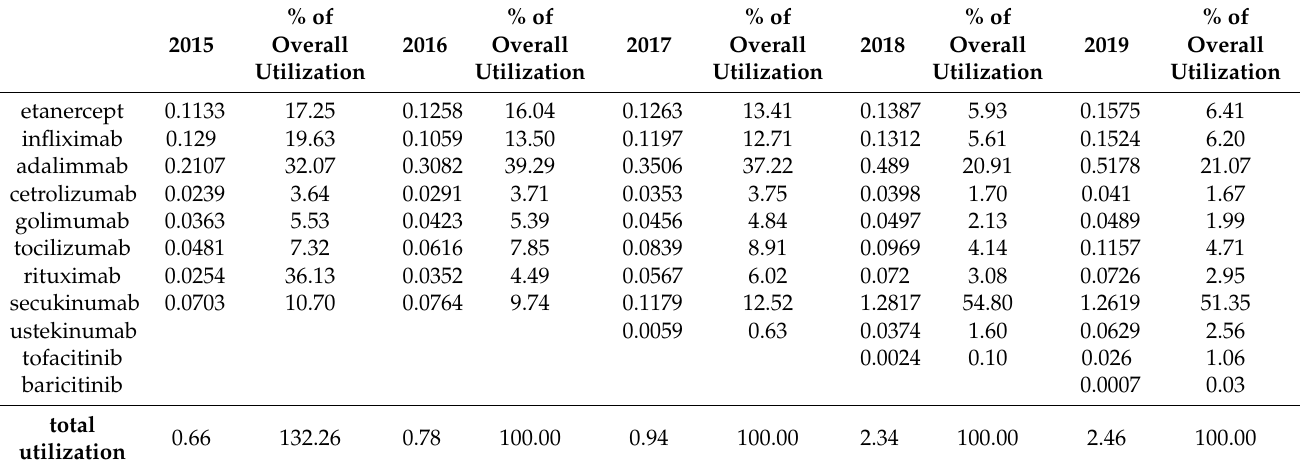
Table 4. Share of utilization in